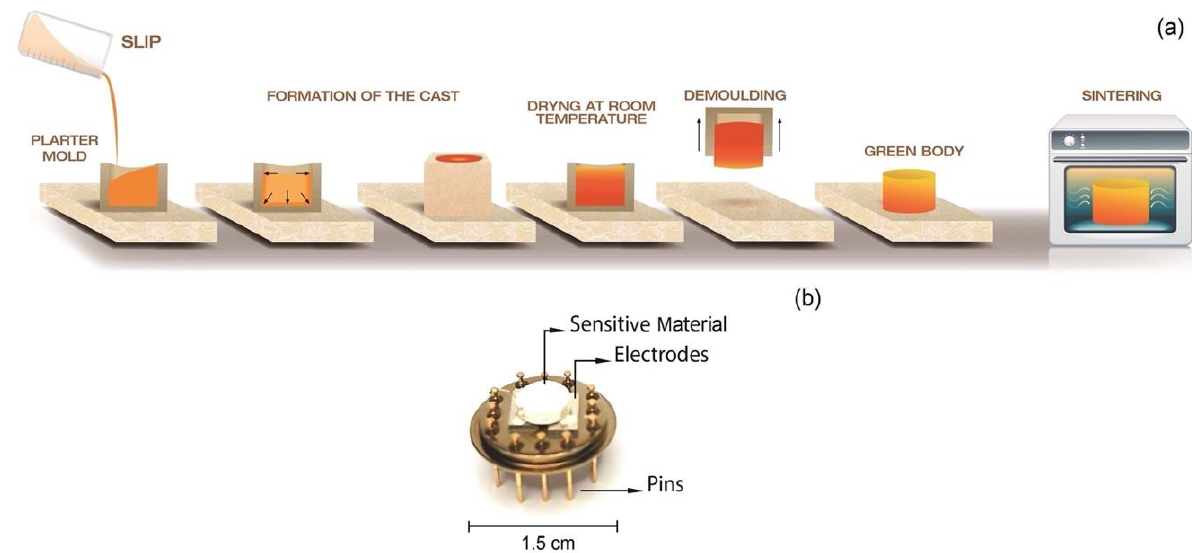
Figure 1. ( a ) Scheme of the procedure carried out for shaping the gas-sensitive material. ( b ) Photo- graph of a sensor containing the sensitive material and the electrodes integrated in a TO-8 package.